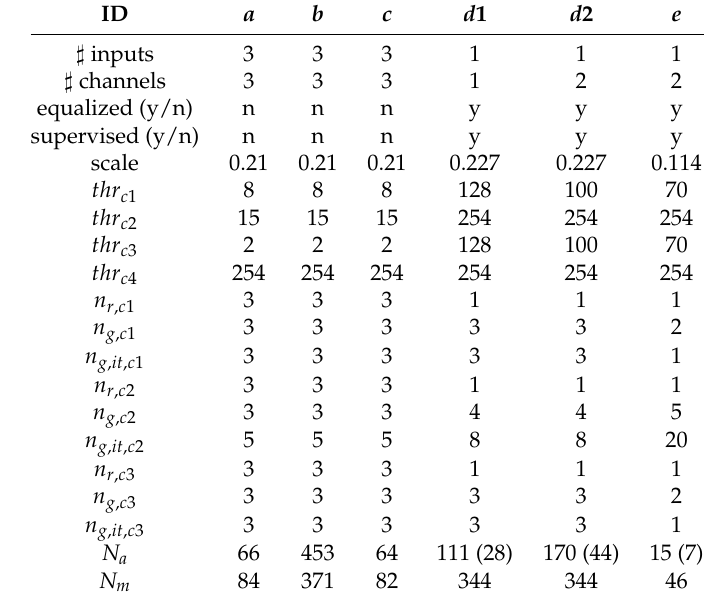
Table 1. Image characteristics ( (cid:93) input images, (cid:93) fluorescence channels) and values of parameters used for CM mask generation and CX43 quantification. Thresholds are set in 8-bit range ([0, 255]). Noise removal and growth parameters n r , ci and n g , ci are expressed as matrix rank, while n g , ci , it is expressed as number of iterations. The last two rows contain the number of detected CMs in the automatic ( N a ) and manual ( N m ) masks. For images d and e , the supervised mode was additionally used to filter the results of the automatic algorithm. The number of CMs detected in the supervised mode are presented in brackets next to the value of N a obtained in the unsupervised mode.